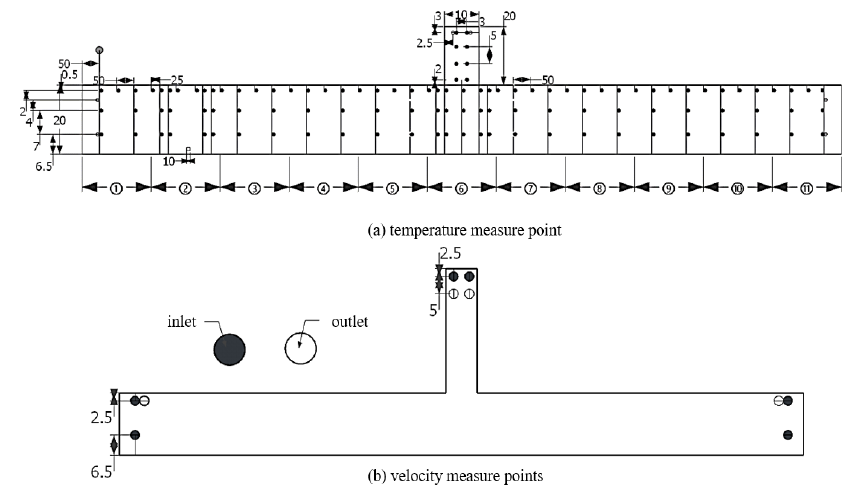
Figure 2. Arrangement of measure